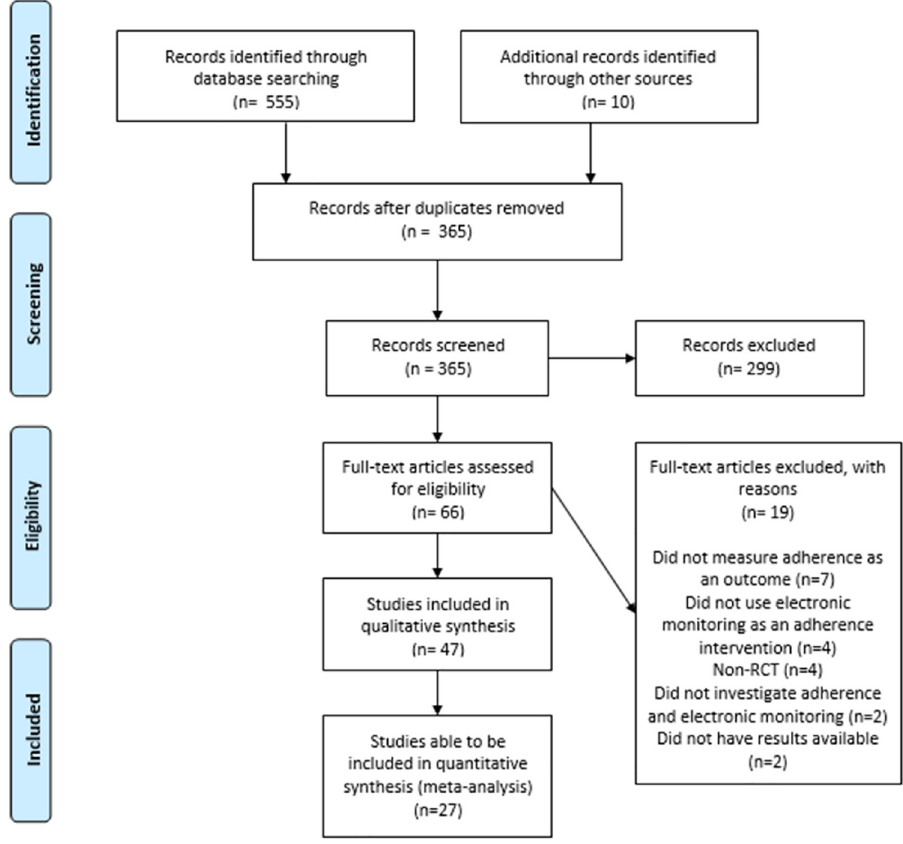
Fig 1. PRISMA flow diagram of eligible